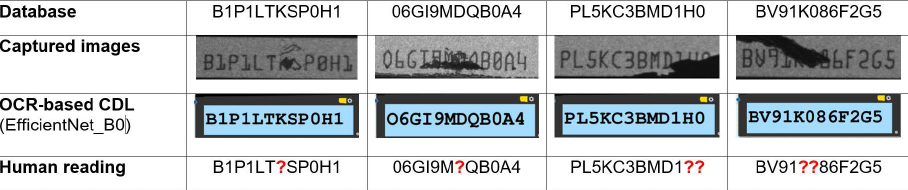
Figure 11. Examples of better classification performances of EfficientNet-B0 superior to human